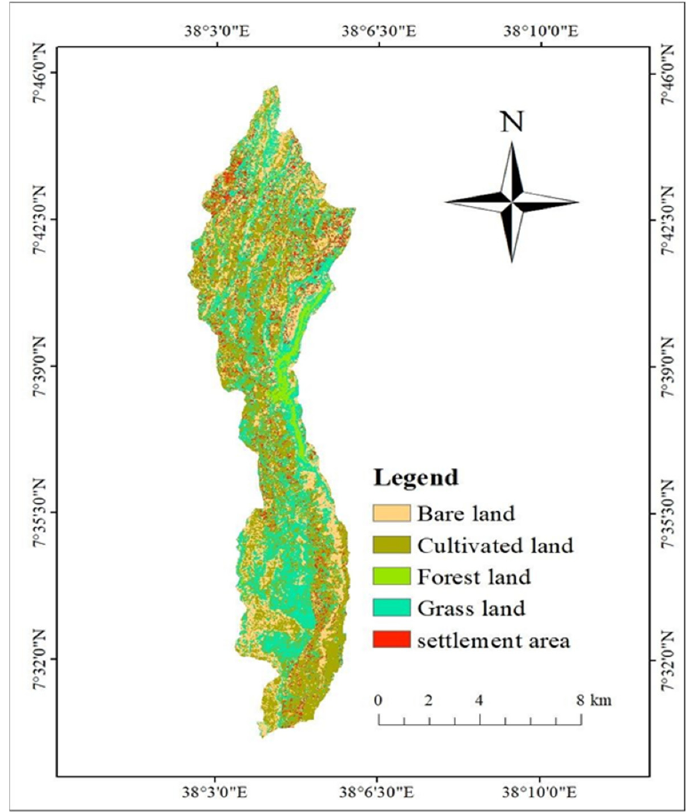
Figure 4. Matenchose watershed LULC Map of 2003. In this situation, the percentage change in ESV in response to changes in the Maten- chose watershed’s LULC over a specific time-period was measured using the elasticity of ESV change.